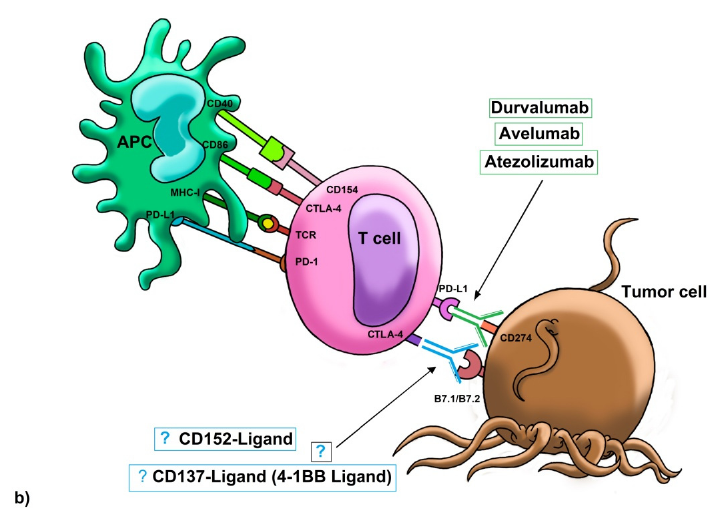
Figure 3. ( a ) Immunotherapy. ( b ) Lack of immunotherapy.